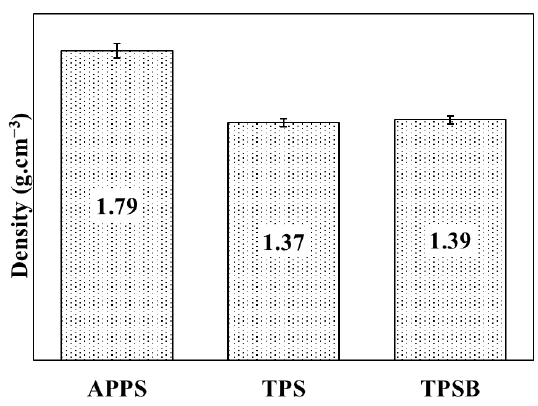
Figure 2. Density of APPS, TPS and TPSB.